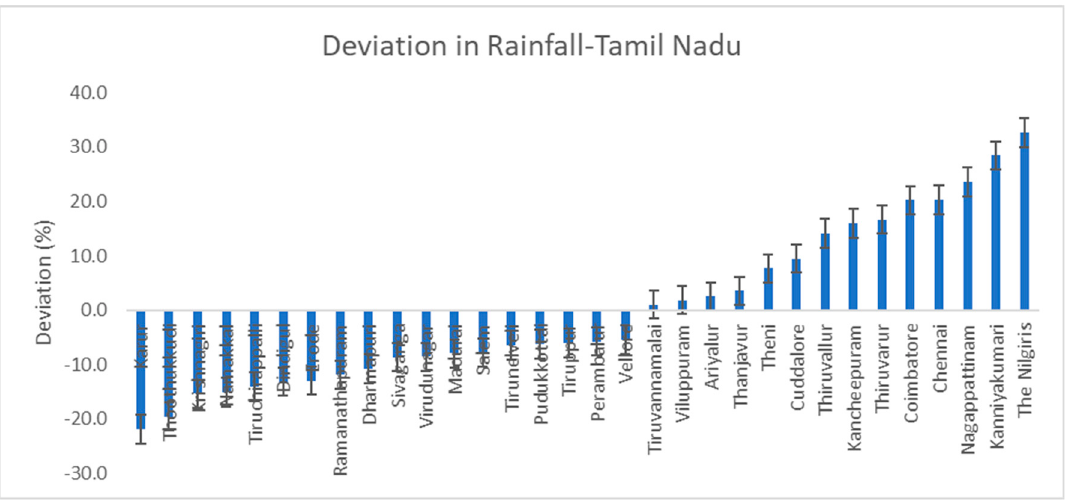
Figure 3. District-wise difference in rainfall distribution from the state’s mean over 1970 to 2017.